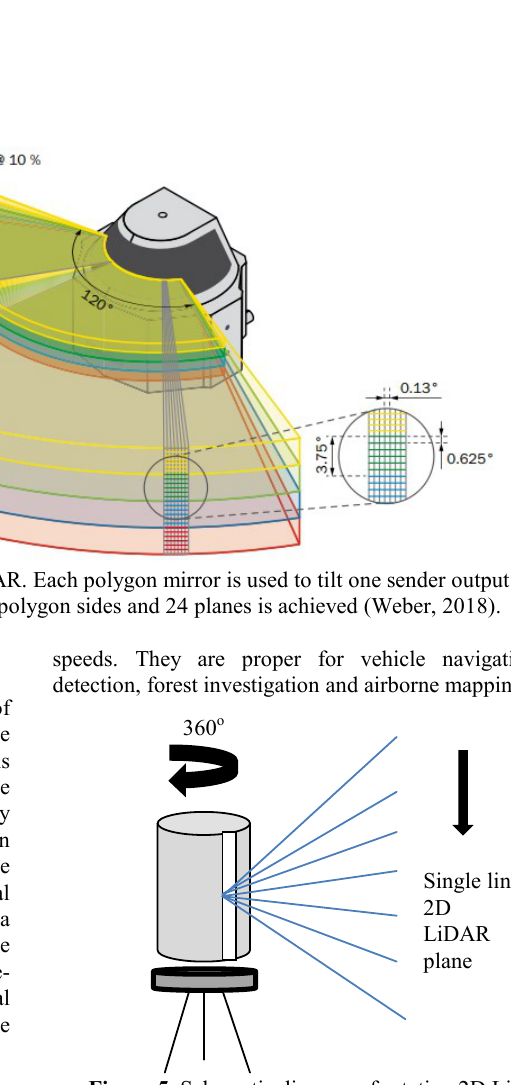
Figure 5. Schematic diagram of rotating 2D LiDAR. 2D LiDAR plane perpendicular to 360 degree rotation